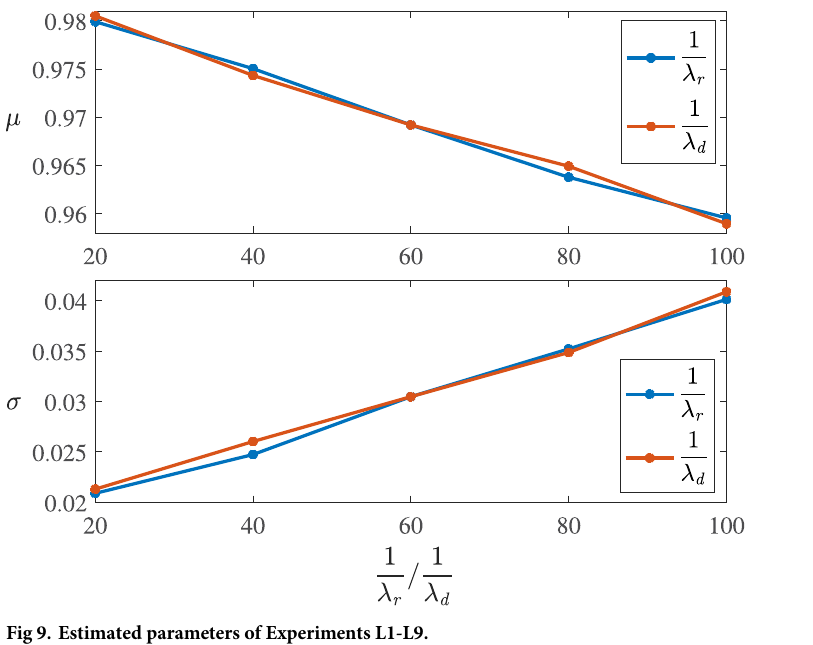
Fig 9. Estimated parameters of Experiments